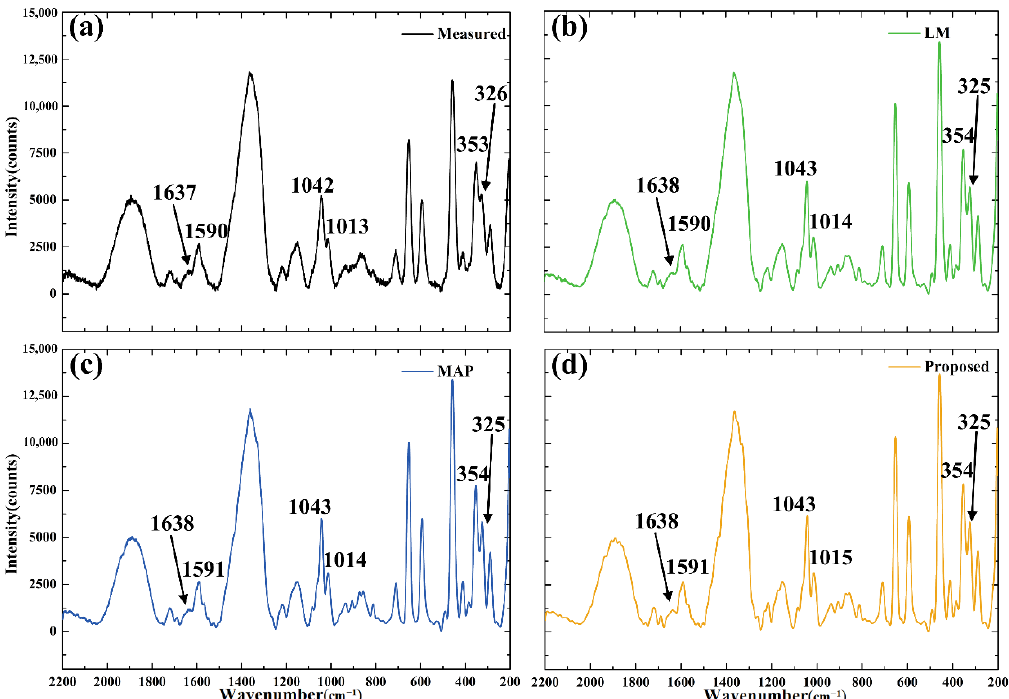
Figure 9. ( a ) Ketamine (C 13 H 16 ClNO) measured spectrum and reconstructed spectra with spectral range from 2200 to 200 cm −1 by ( b ) the LM method; ( c ) the MAP method; ( d ) the proposed method.